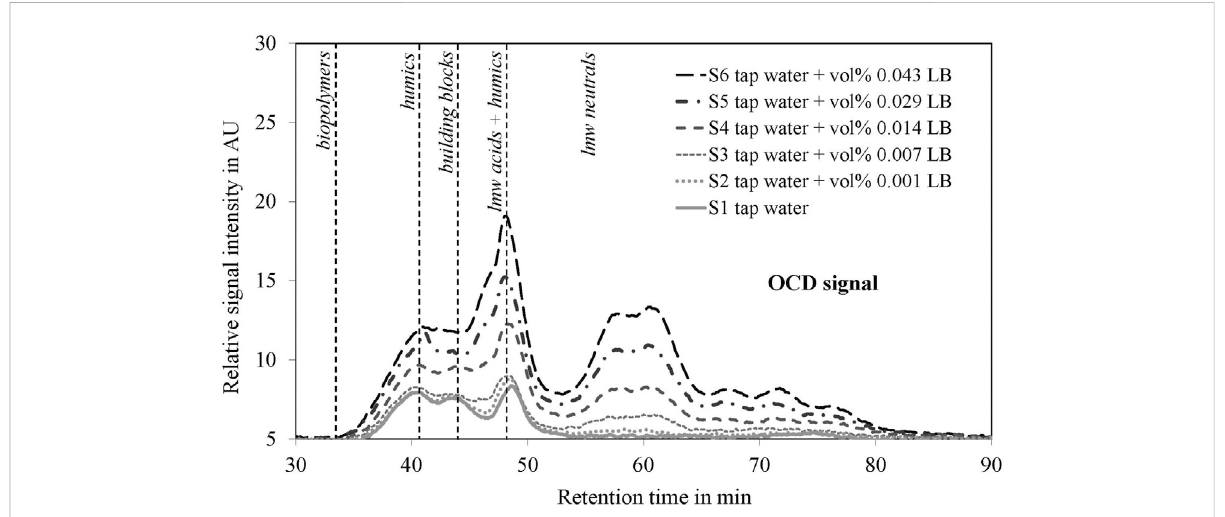
FIGURE 3 Characterization of organic carbon by LC-OCD analysis for all samples (S1 – S6). Differences in biopolymers, humics, building blocks, low molecular weight (lmw) acids + humics and lmw neutrals are show. The analyses were performed before the start of the real-time monitoring